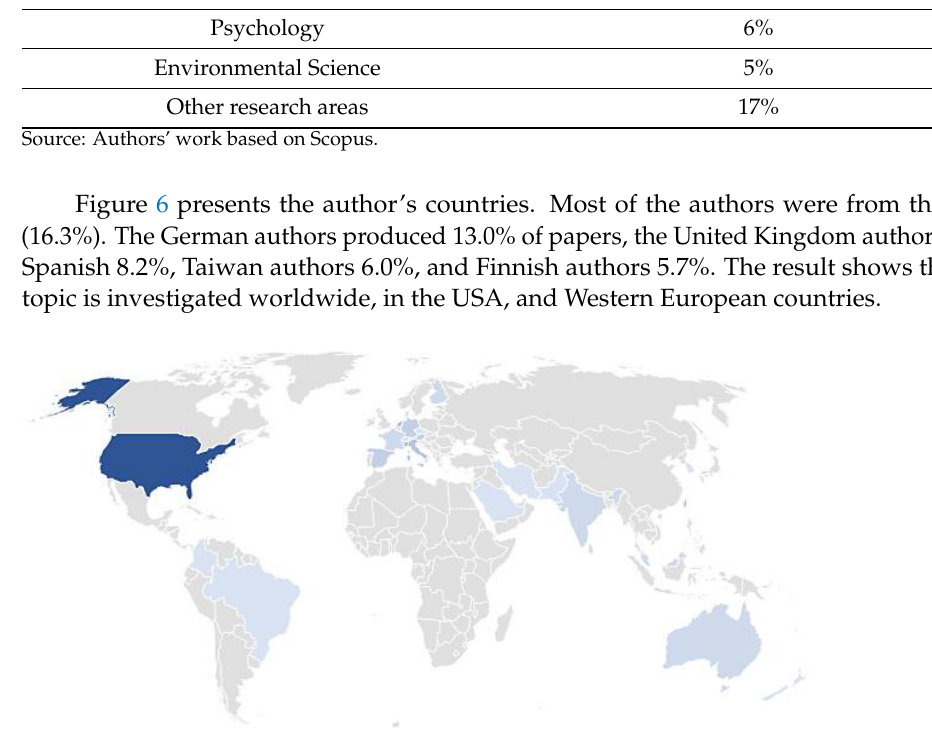
Figure 6. The research paper’s countries; Source: Authors’ work based on Scopus.